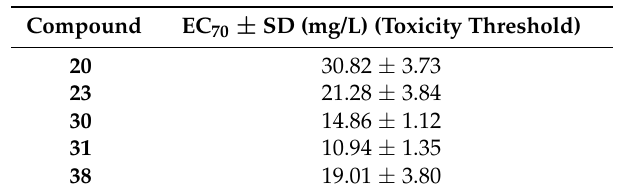
Table 2. Cytotoxic effect of compounds 20 , 23 , 30 , 31 and 38 on human embryonic kidney cells (HEK-293) after 24 h of